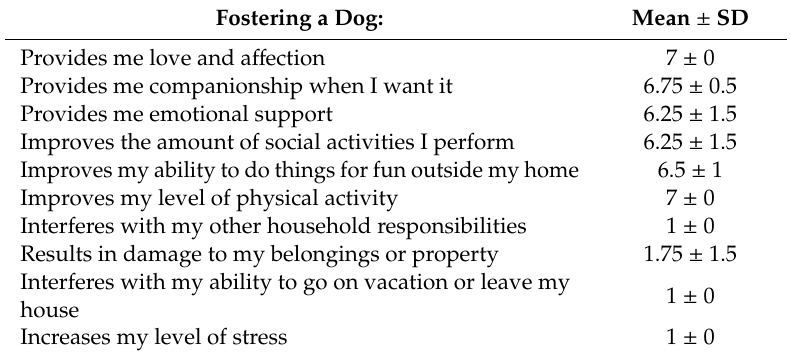
Table 2. Modified Dog-Owner-Specific Quality of Life (DOQOL) Questionnaire responses ( n = 4).